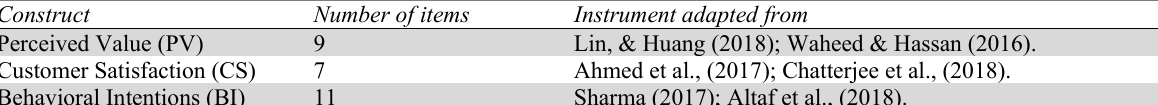
Items included in this survey Construct Number of items Instrument adapted from Perceived Value (PV) 9 Lin, & Huang (2018); Waheed & Hassan (2016). Customer Satisfaction (CS) 7 Ahmed et al., (2017); Chatterjee et al., (2018).